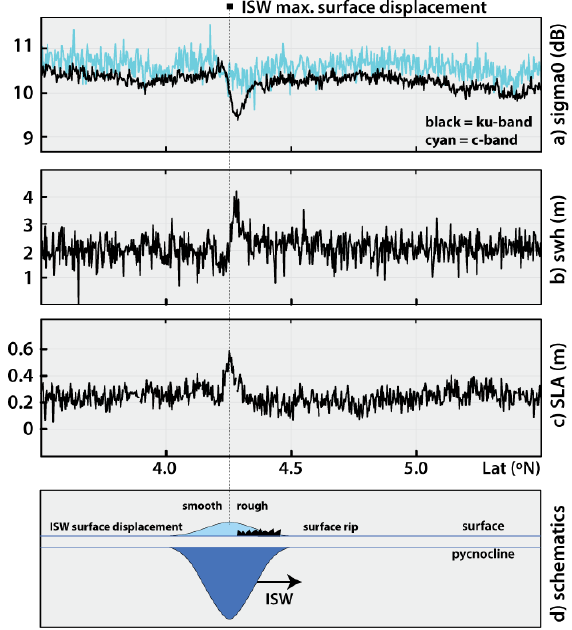
Figure 4. ( a ) Along-track backscatter (σ 0 ) for Ku-band (black) and C-band (light blue). ( b ) Along-track SRAL record of SWH (significant wave height) showing a pronounced increase of retrieved SWH at approximately 4.3°N, from the average 2 m to 4 m. ( c ) Sea level anomaly (SLA) in SAR mode for the same ground segment where a sea surface elevation anomaly of approximately 0.4 m can be seen at the same location of the ISW signature. ( d ) Schematic representation of an interfacial ISW of depression showing a maximum of the surface water displacement over its trough, in between its rough and smooth surface manifestations. See text for more details.